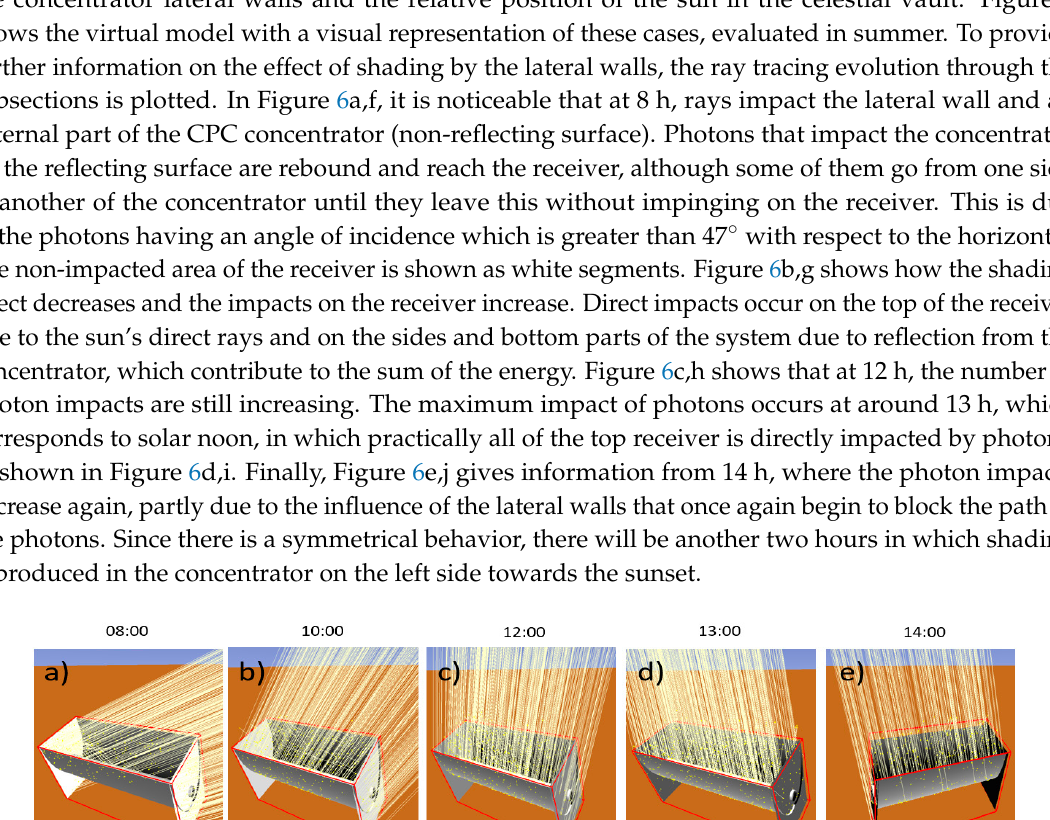
Figure 7. Comparison of available energy on receiver per season in static setup (21°).